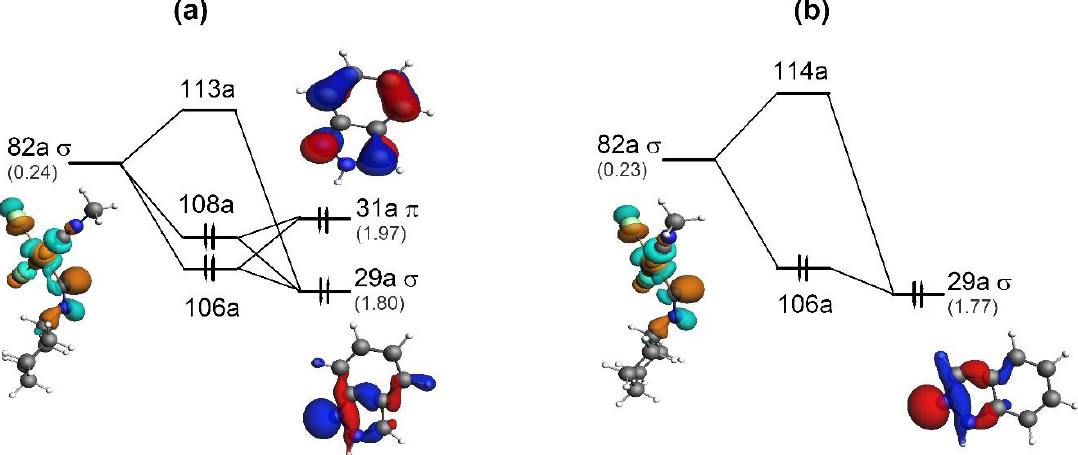
Figure 6. Molecular orbital diagrams for the PdC ← N ( σ -type) interaction in TS14 ( a ) and TS6 ( b ). Corresponding orbitals populations (in e) are given in parentheses. Isosurface values are 0.05 e 1/2 /Å 3/2 .